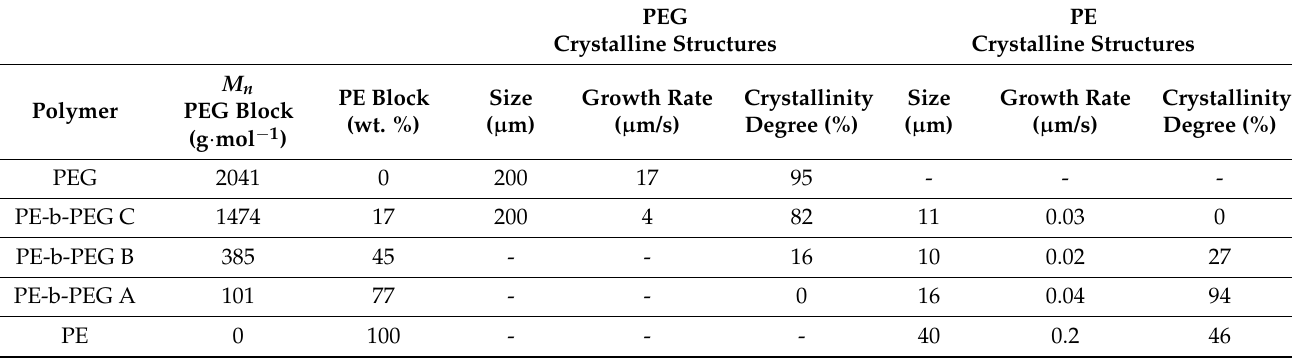
Table 7. Size and growth rate of PE and PEG crystalline structures determined by optical microscopy in combination with a hot-stage, and crystallinity degree (determined by DSC) for PE-b-PEG copoly- mers and PE and PEG homopolymers.